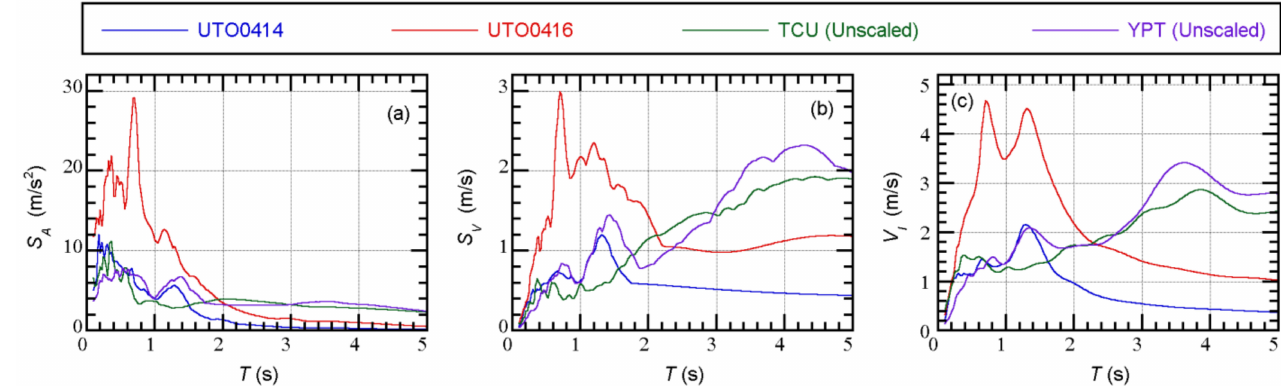
Figure 17. Horizontal response spectra of the recorded ground motions: ( a ) Elastic acceleration response spectrum (damping ratio: 0.05); ( b ) elastic velocity response spectrum (damping ratio: 0.05); ( c ) elastic total input energy spectrum (damping ratio: 0.10).